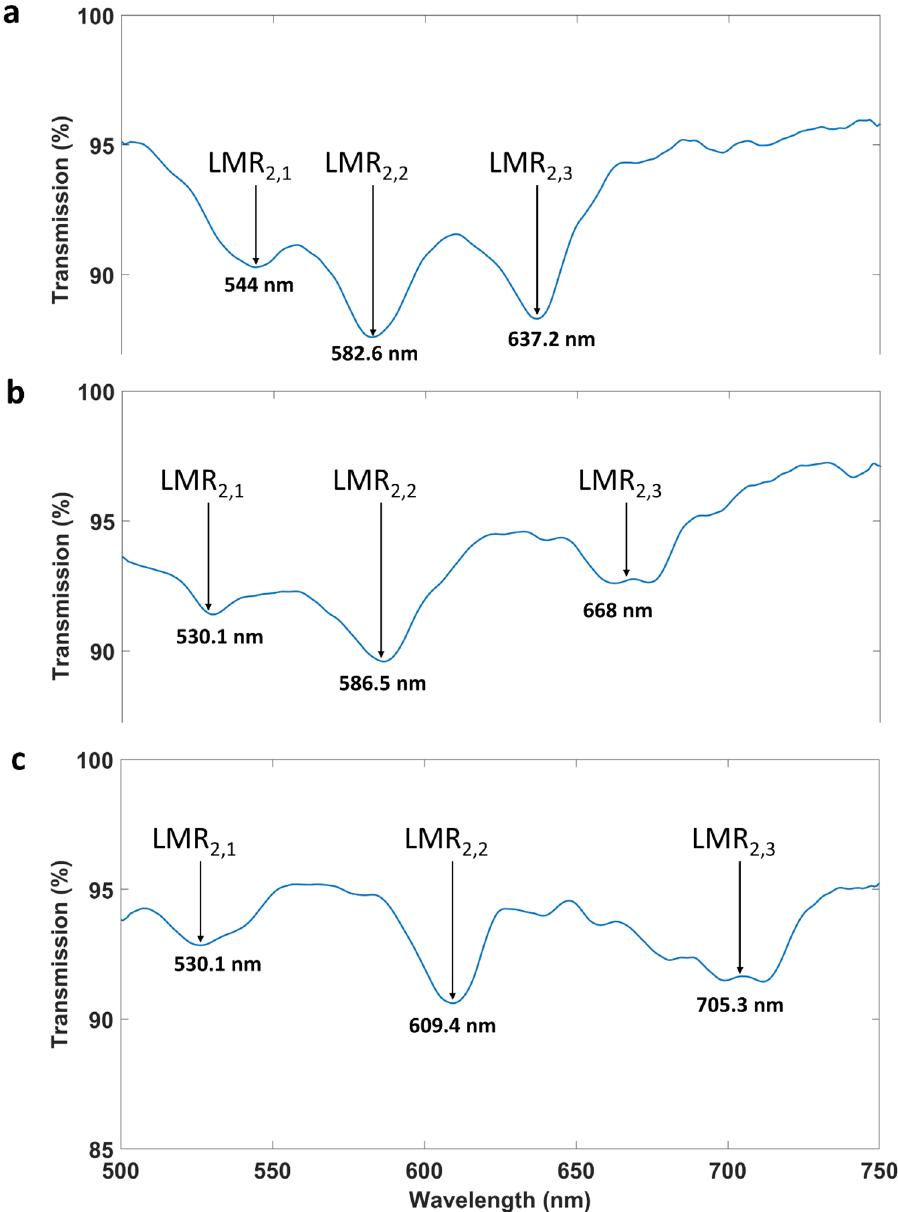
Figure 4. LMRs generated with device 2 for different deposition angles. A mask was used to separate three different regions during the coating process. Three different angles of deposition were analysed: (a) 30º, (b) 45º, and (c) 60º.